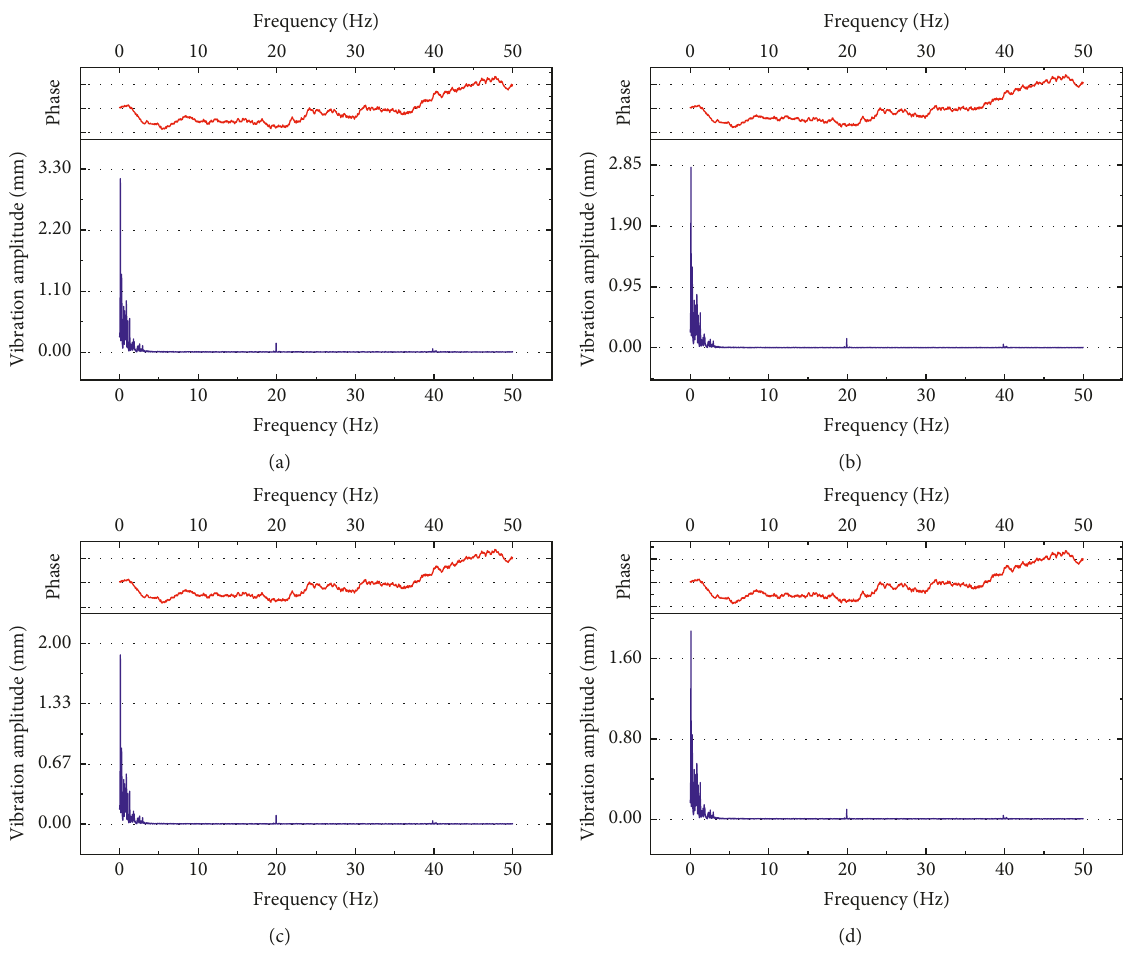
Figure 7: Analysis results of simulated data change. (a) A-F-P: 400m. (b) A-F-P: 300m. (c) A-F-P: 200m. (d) A-F-P: 100m.